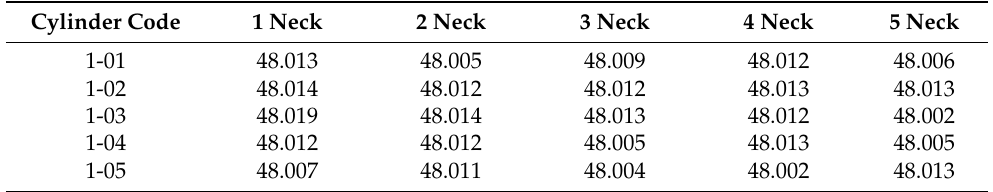
Table 2. Main bearing bore diameter of cylinder block (mm).